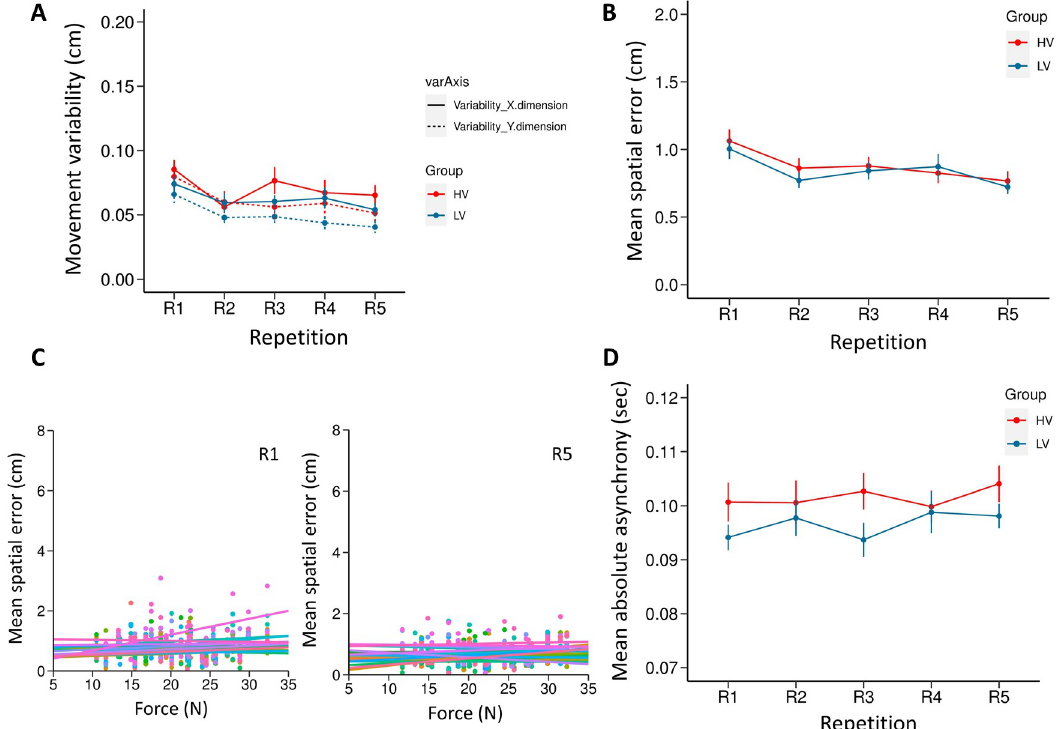
Fig 8. Results of Experiment 3. (A) Normalized variability of participant’s movement in the horizontal and vertical dimension. (B) Spatial error as a measure of individual performance. The spatial error at each repetition is an average of all 8 configurations from each of the 8 blocks. (C) Repeated measures correlation analysis between the force perturbation experienced and the spatial error of the participants in the HV group, for R1 and R5 separately. Each participant’s data and corresponding rmcorr fit lines are shown in different colors. (D) Absolute Asynchronies as a measure of joint performance. All error bars display standard error of mean.